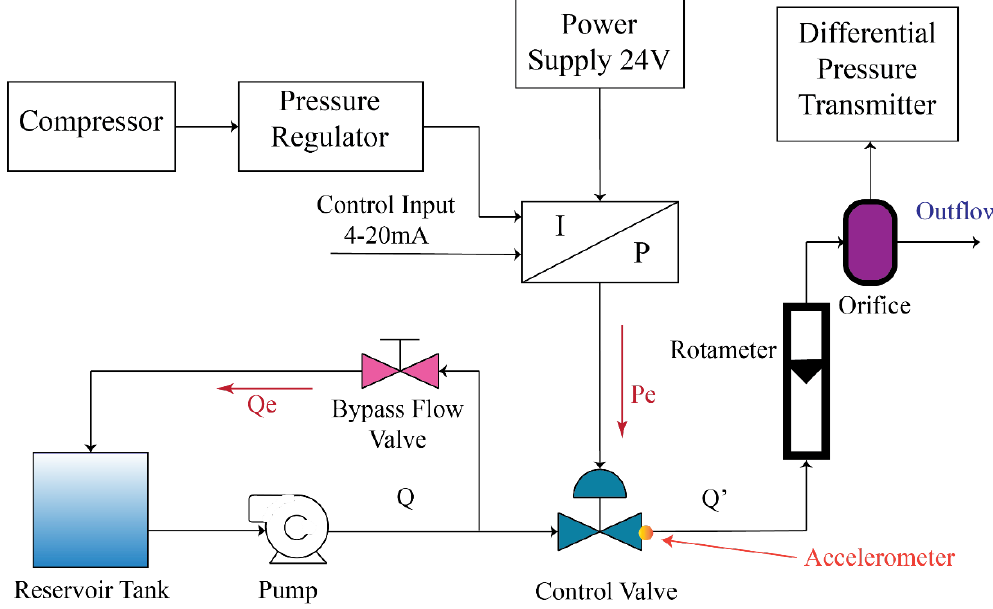
Figure 4. Faults considered into the proposed technique .